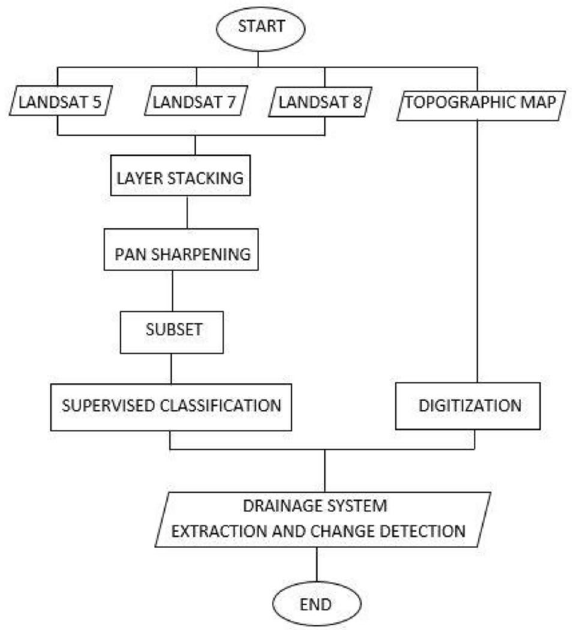
Fig. 2 Methodological flow chat for the study